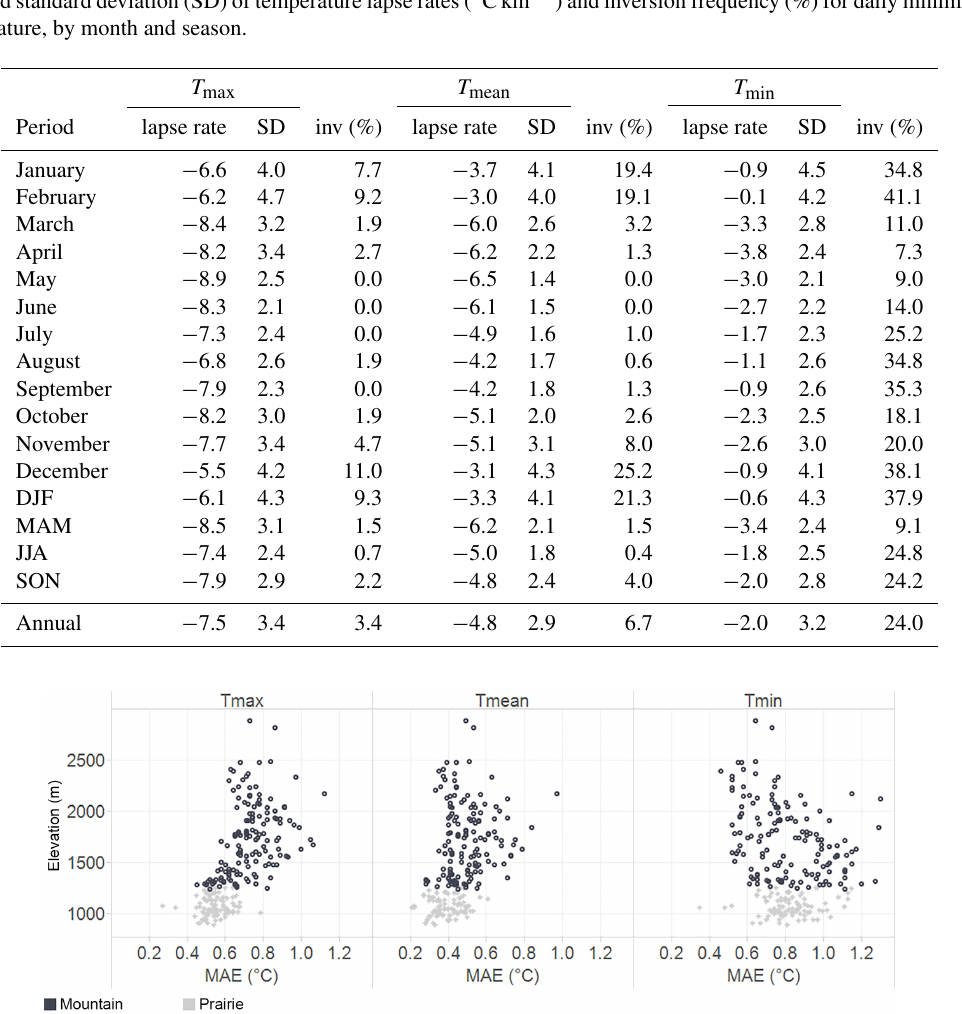
sure. Mean values vary from 0.5 to 0.8 for T max , 0.4 to